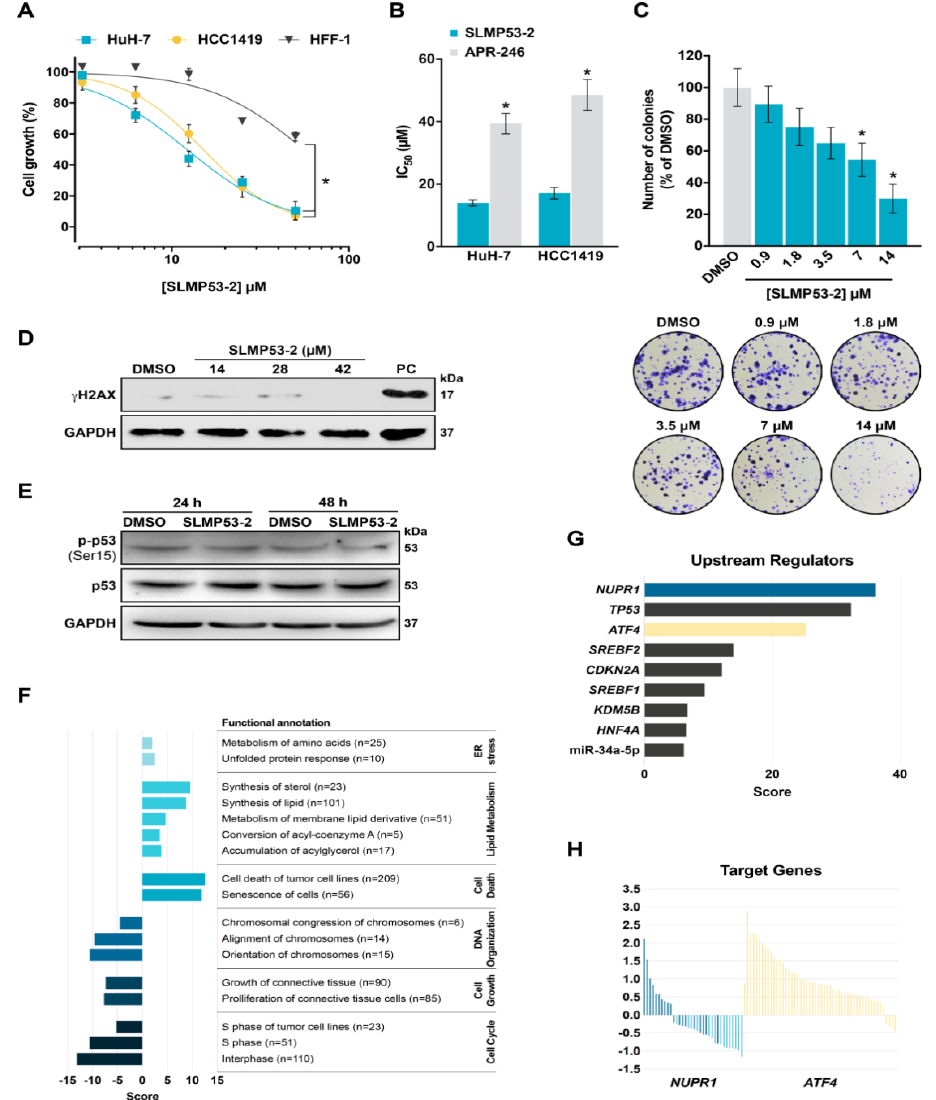
Figure 2. SLMP53-2 inhibits the growth of mutp53-Y220C-expressing tumor cells with no genotoxicity, leading to the di ff erential expression of genes involved in cell cycle and death, lipid metabolism, and endoplasmic reticulum (ER) stress. ( A ) Concentration-response curves for SLMP53-2 in human non-tumoral HFF-1 and tumor mutp53-Y220C-expressing HuH-7 and HCC1419 cells, analyzed by sulforhodamine B (SRB) assay after 48 h treatment with 3.12–50 µ M SLMP53-2. Data are mean ± SEM ( n = 5); * p < 0.05, extra sum-of-squares F test. ( B ) IC 50 values of SLMP53-2 and APR-246 in HuH-7 and HCC1419 cells were determined by SRB assay after 48 h treatment with 3.12–50 µ M SLMP53-2 or APR-246. Data are mean ± SEM ( n = 5); * p < 0.05, two-way ANOVA with Sidak’s multiple comparison test. ( C ) Effect of SLMP53-2 in HuH-7 cell colony formation, analyzed after 14 days incubation with SLMP53-2; a representative experiment is shown. Data are mean ± SEM ( n = 5); values